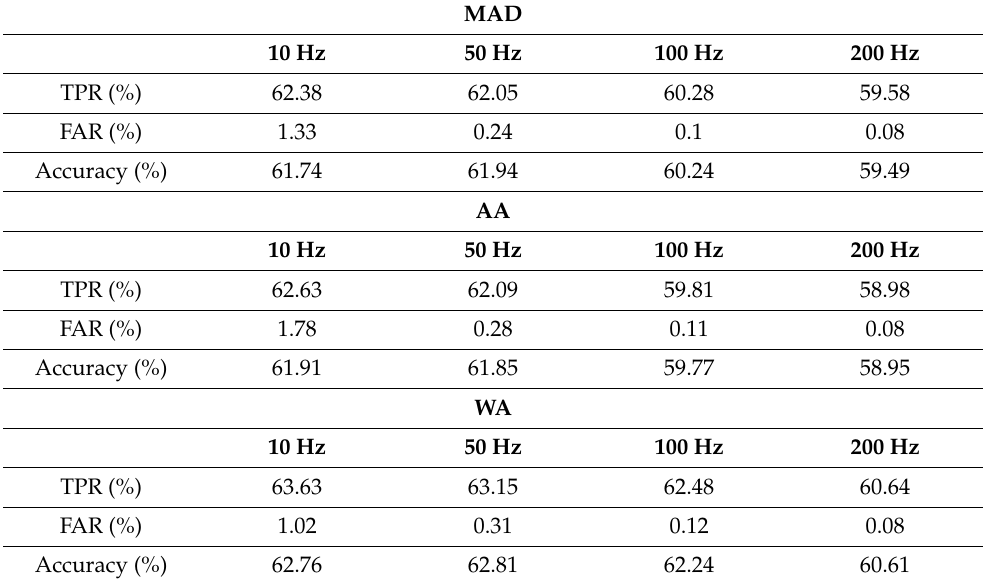
Table 2. Detection performances of pre-norm algorithm at different firing rates at SNR = 0 dB (C =